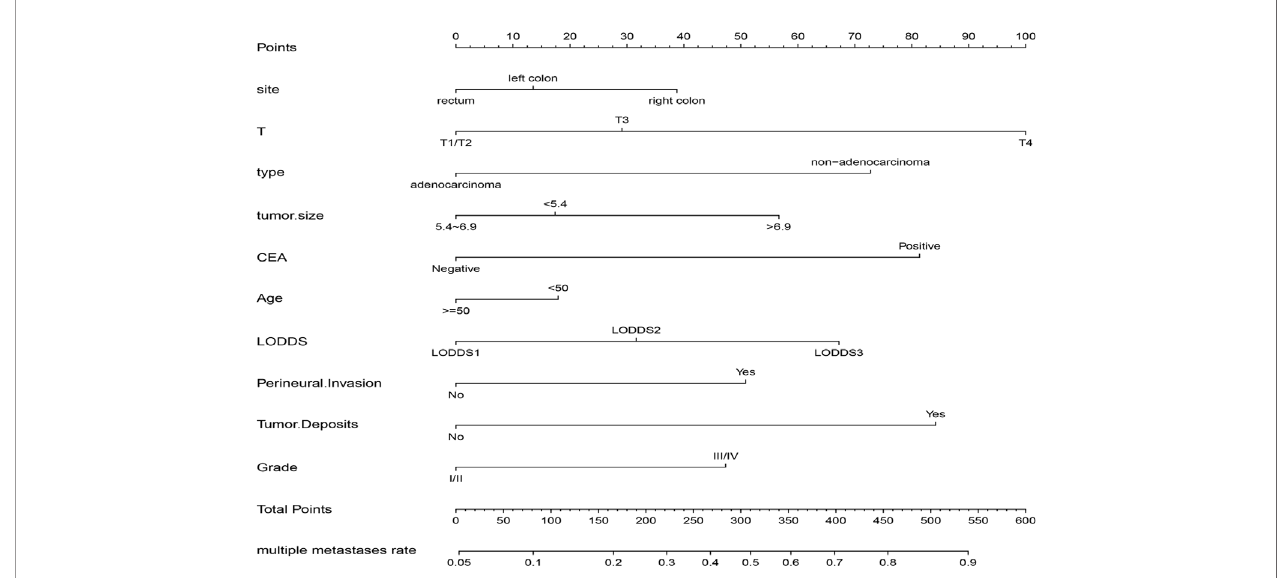
FIGURE 4 | The nomogram for predicting the risk of multiple metastases in CRC. CEA, carcinoembryonic antigen; LODDS, the log of positive lymph nodes.